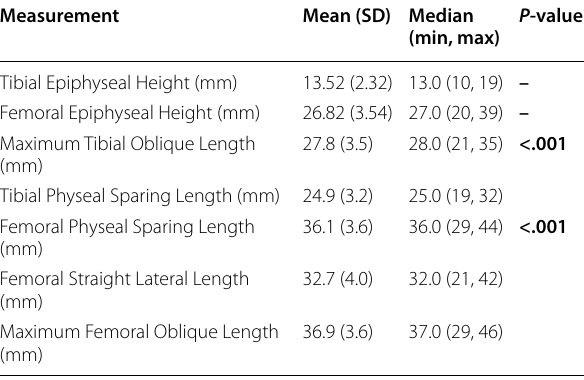
Table 4 Epiphyseal